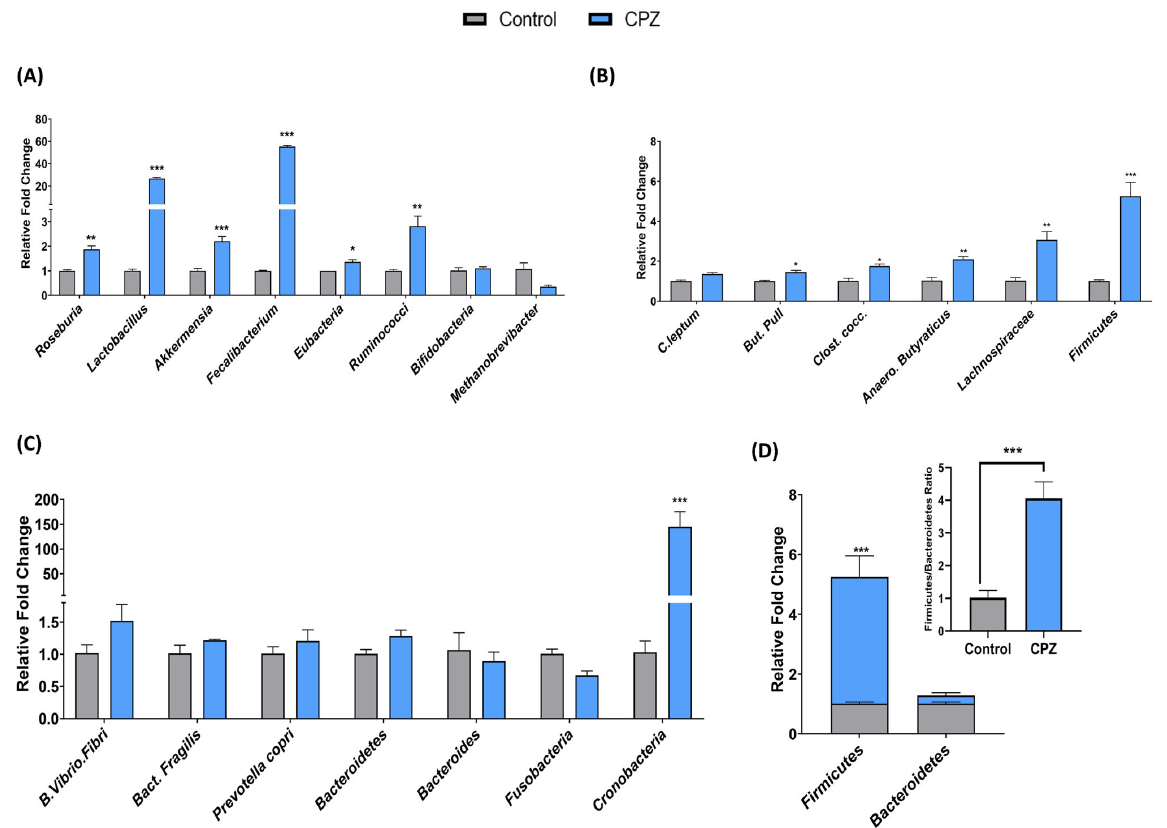
Figure 3. Effect of CPZ rectal administration on gut microbiota. ( A , B ) Relative bacterial abundances of Gram +ve bacteria in cecum, ( C ) relative bacterial abundances of Gram − ve bacteria in cecum and ( D ) relative abundance of firmicutes and bacteroidetes in cecum ( n = 3). Mice were divided into two groups—Control (administered vehicle rectally) and CPZ (administered 531 μ M CPZ rectally). Treatment was given for two weeks. After sacrifice, the cecum content was collected, weighed and bacterial DNA was isolated using a commercial kit. The DNA quantity was measured, and quality was assessed with agarose gel electrophoresis. The DNA was subjected to qRT-PCR based changes in gene expression of various gut bacteria. The data were normalized with total bacteria as internal control and presented in the form of relative fold change. All data are represented as mean ± SEM. Intergroup variations were assessed using a Student’s unpaired t -test. * p 0.05, ** p 0.01, *** p 0.001 versus